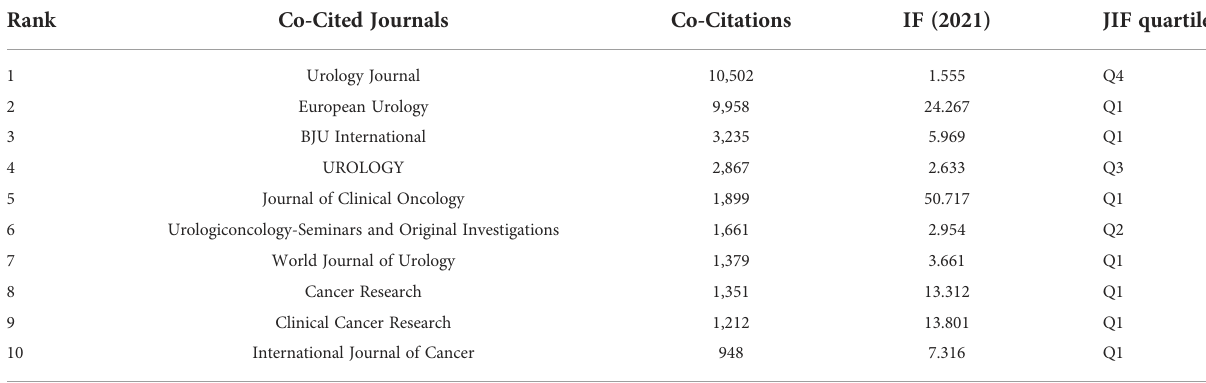
TABLE 5 Top 10 Co-Cited